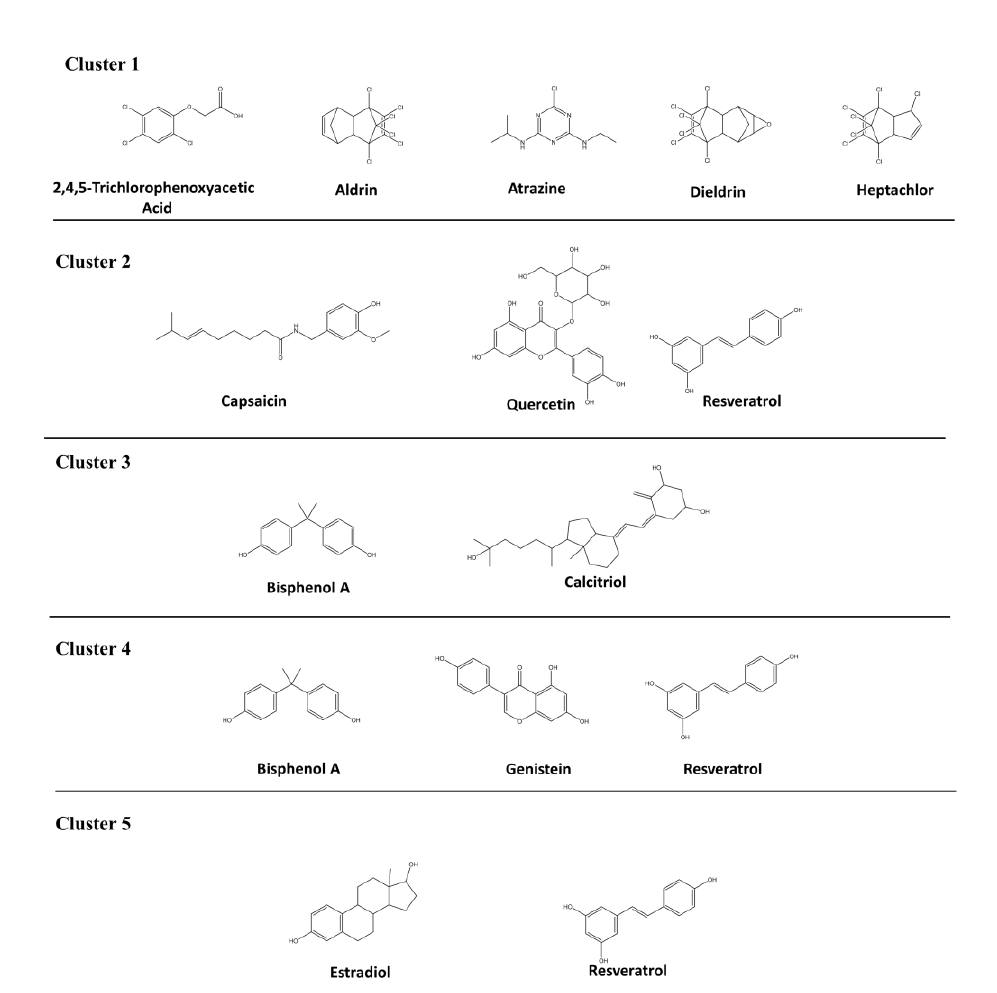
Figure 4. Two-dimensional structures of androgenic activity compounds associated with diabetes mellitus.